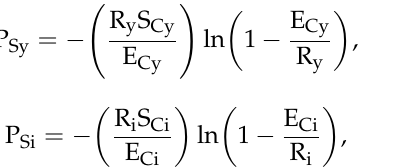
Wet canopy evaporation Evaporation after